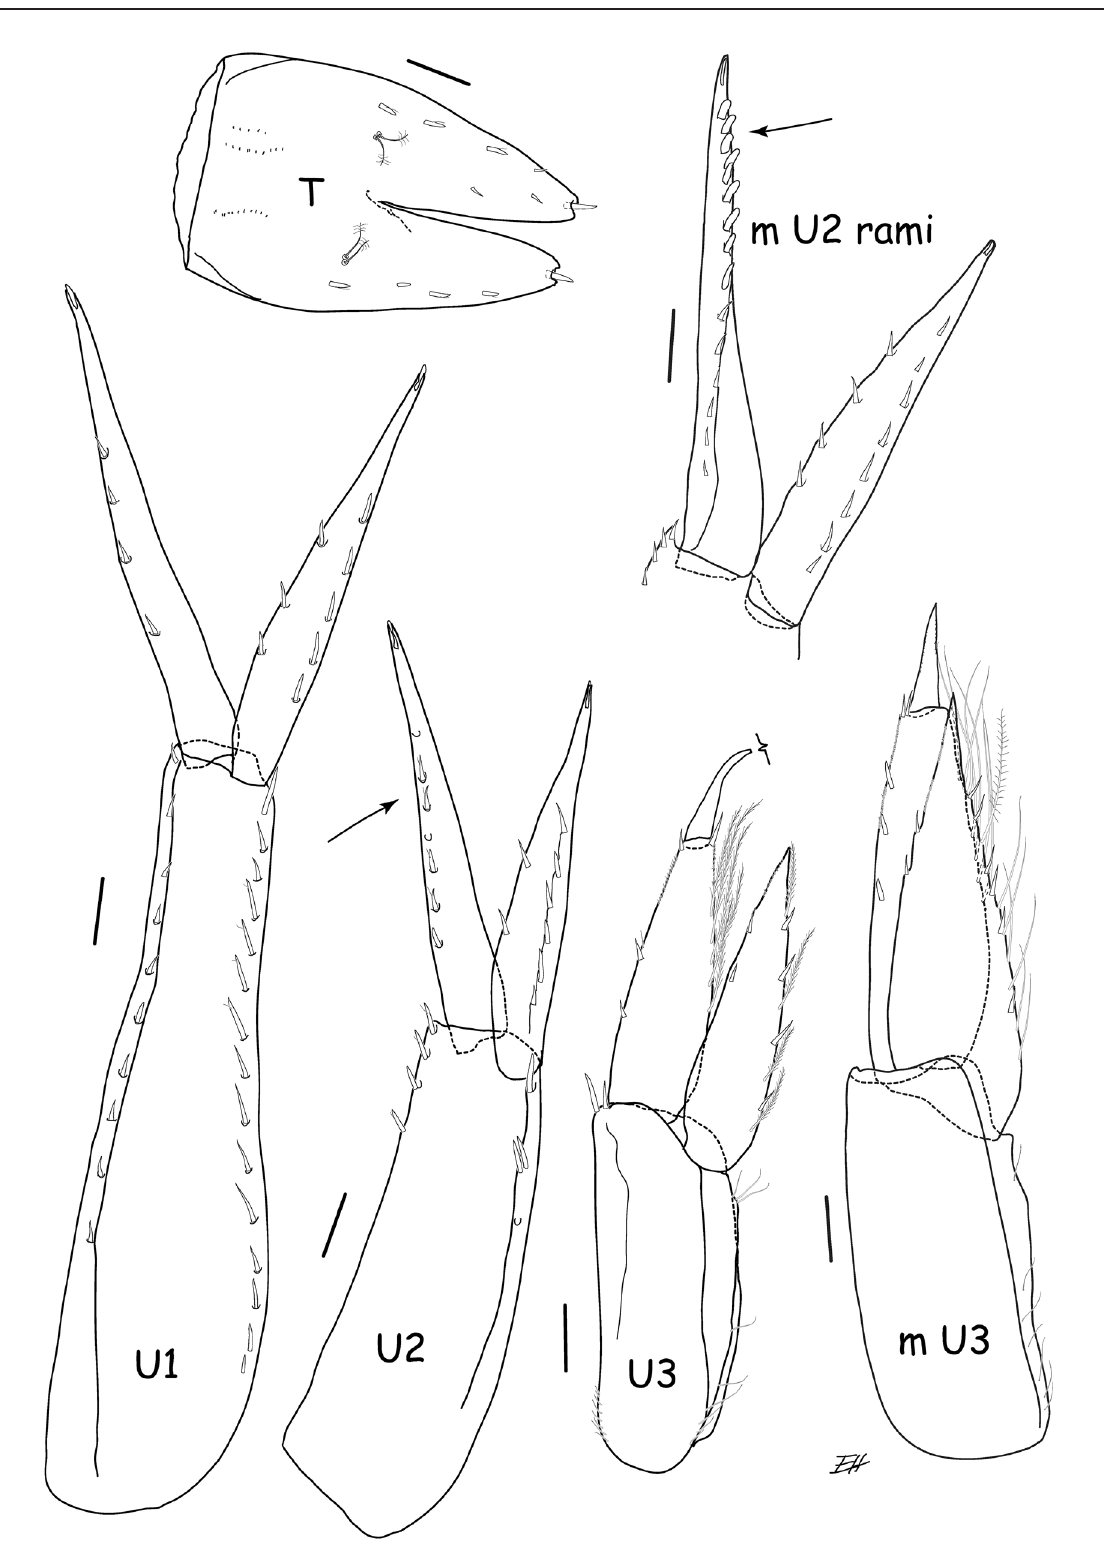
Fig. 25. Abyssorchomene scotianensis (Andres, 1983), ♀, 12 mm (CMNC 2022-0005); ♂, 12.4 mm (CMNC 2022-0007). Outer ramus is oriented on the left side of the uropods. Figures with sex not indicated are of female. Scale bars = 0.1